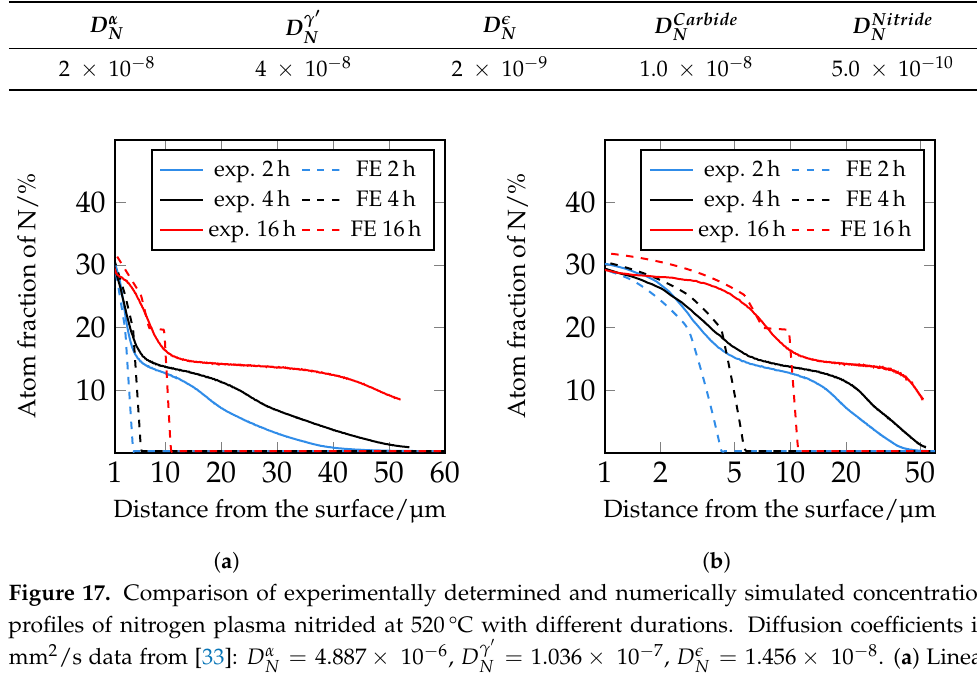
= 4.887 = 1.456 = 1.036 10 − 6 , D γ (cid:48) 10 − 7 , D (cid:101) 10 − 8 . ( a ) Linear N N N × × ×